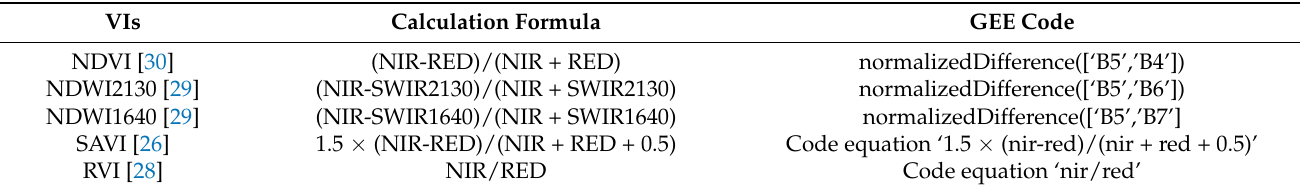
Table 2. Vegetation index (VI) calculation formulas and associated Google Earth Engine (GEE) code. VIs Calculation Formula GEE Code NDVI [30] (NIR-RED)/(NIR + RED) normalizedDifference([‘B5’,’B4’]) NDWI2130 [29] (NIR-SWIR2130)/(NIR + SWIR2130) normalizedDifference([‘B5’,’B6’]) NDWI1640 [29] (NIR-SWIR1640)/(NIR + SWIR1640) normalizedDifference([‘B5’,’B7’] SAVI